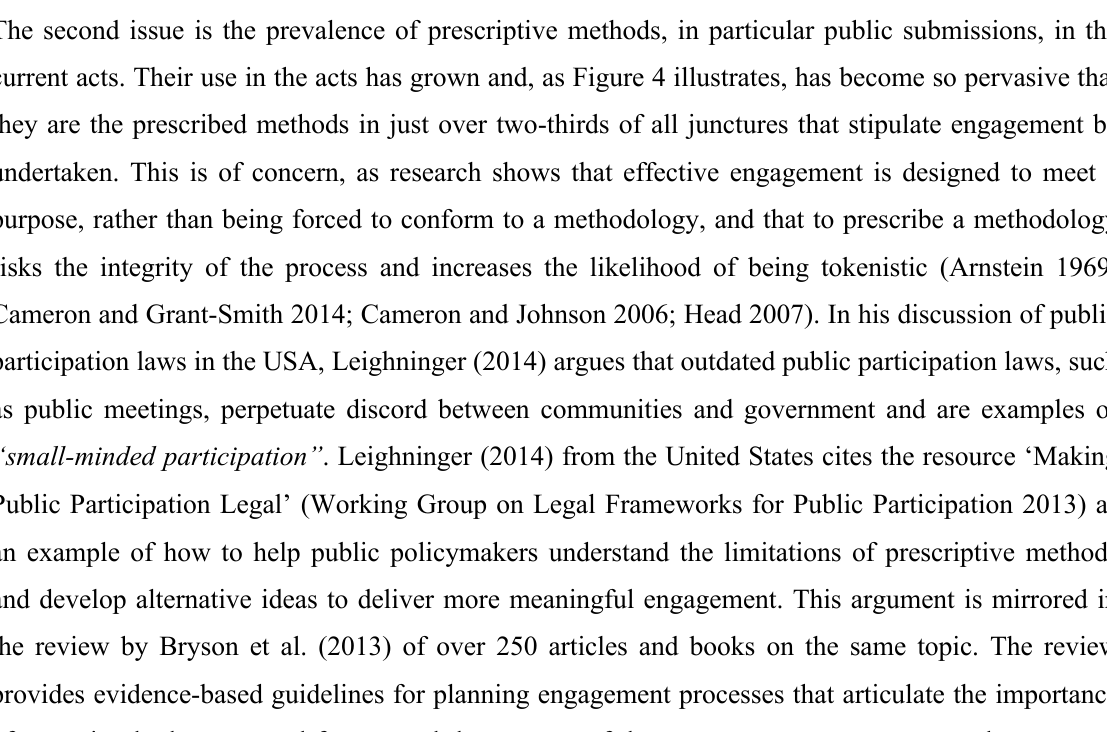
Source: Local Government